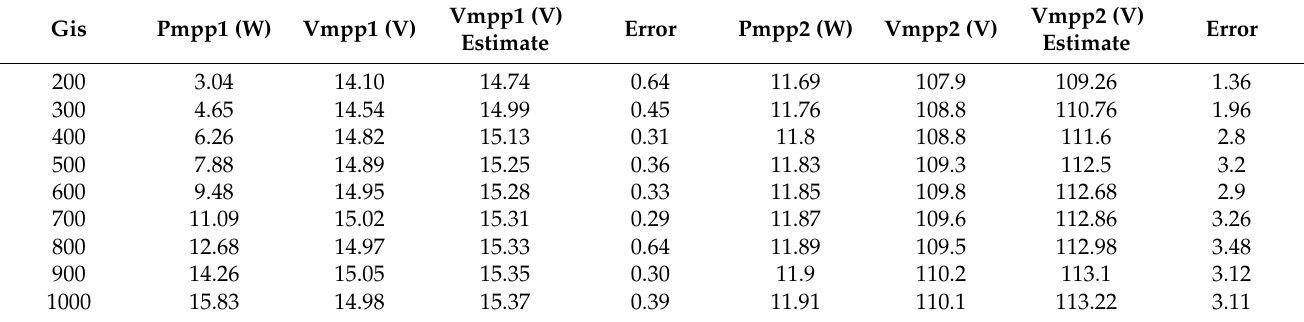
Table 7. The P-V characteristic data for test